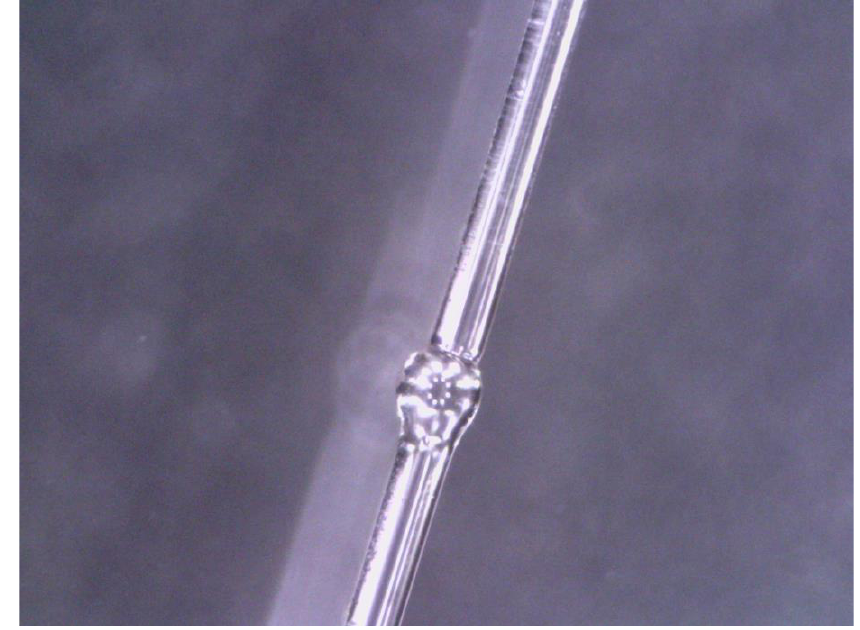
Figure 2. Micrograph of up-taper structure on Yb doped fiber.